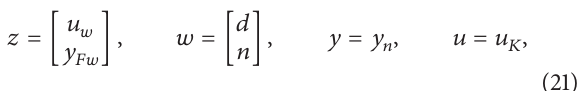
The equivalent two-port diagram in the state space form is shown in Figure 8 for the close loop, and with more